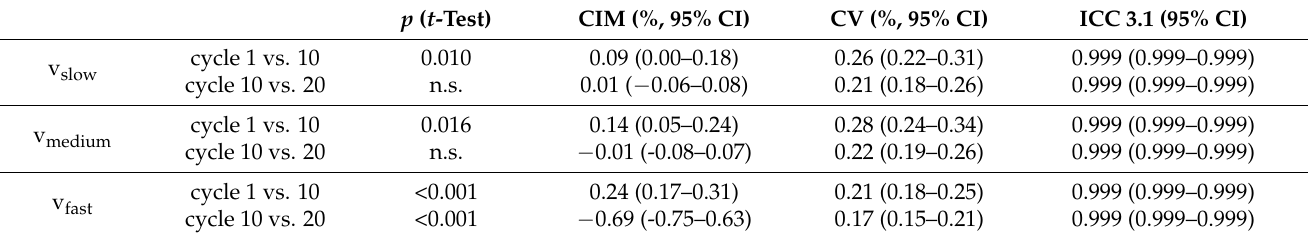
Table 1. Analysis of instrument reliability from the sensor system.